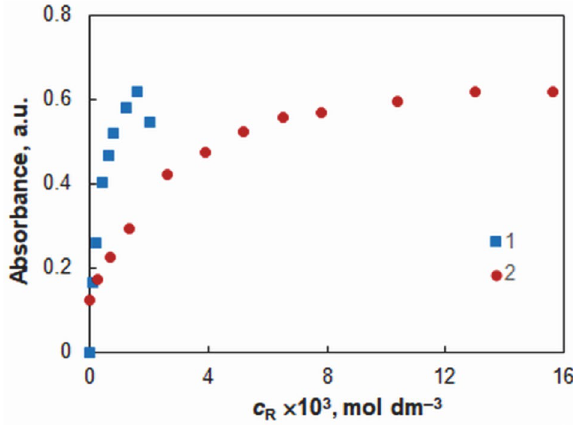
Figure 3. Effect of TAO (1) and A336 (2) concentration on the ab- sorbance. (1) c V = 2 × 10 −5 mol dm −3 , pH 5.0, c A336 = 1.3 × 10 −2 mol